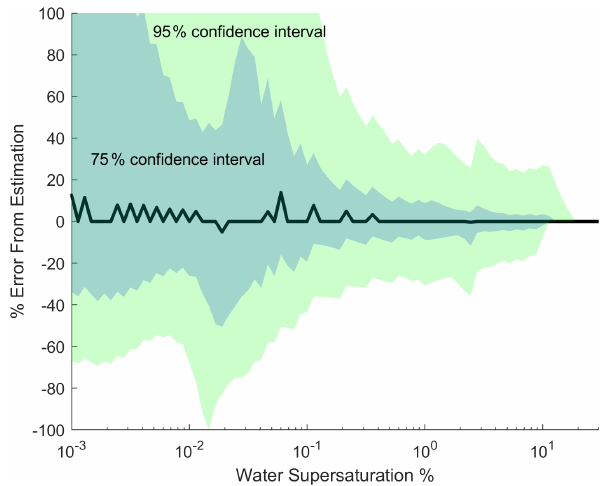
Figure 4. Error estimation of the CCN product constructed from median hygroscopicity data, as compared with that computed for size-dependent κ . The black line depicts the median error, while the dark and light green shaded regions depict 75% and 95% confi- dence intervals,